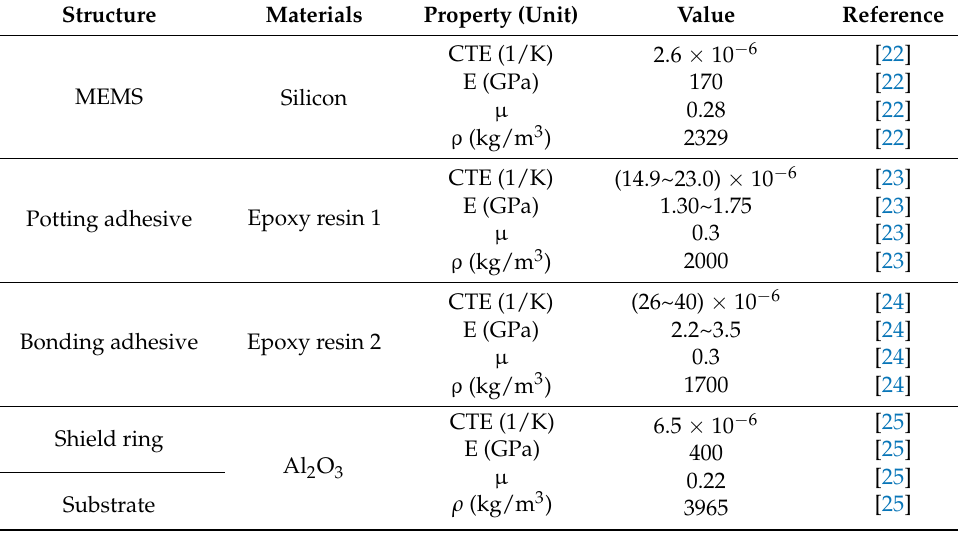
Table 1. Physical properties of the MEMS pressure